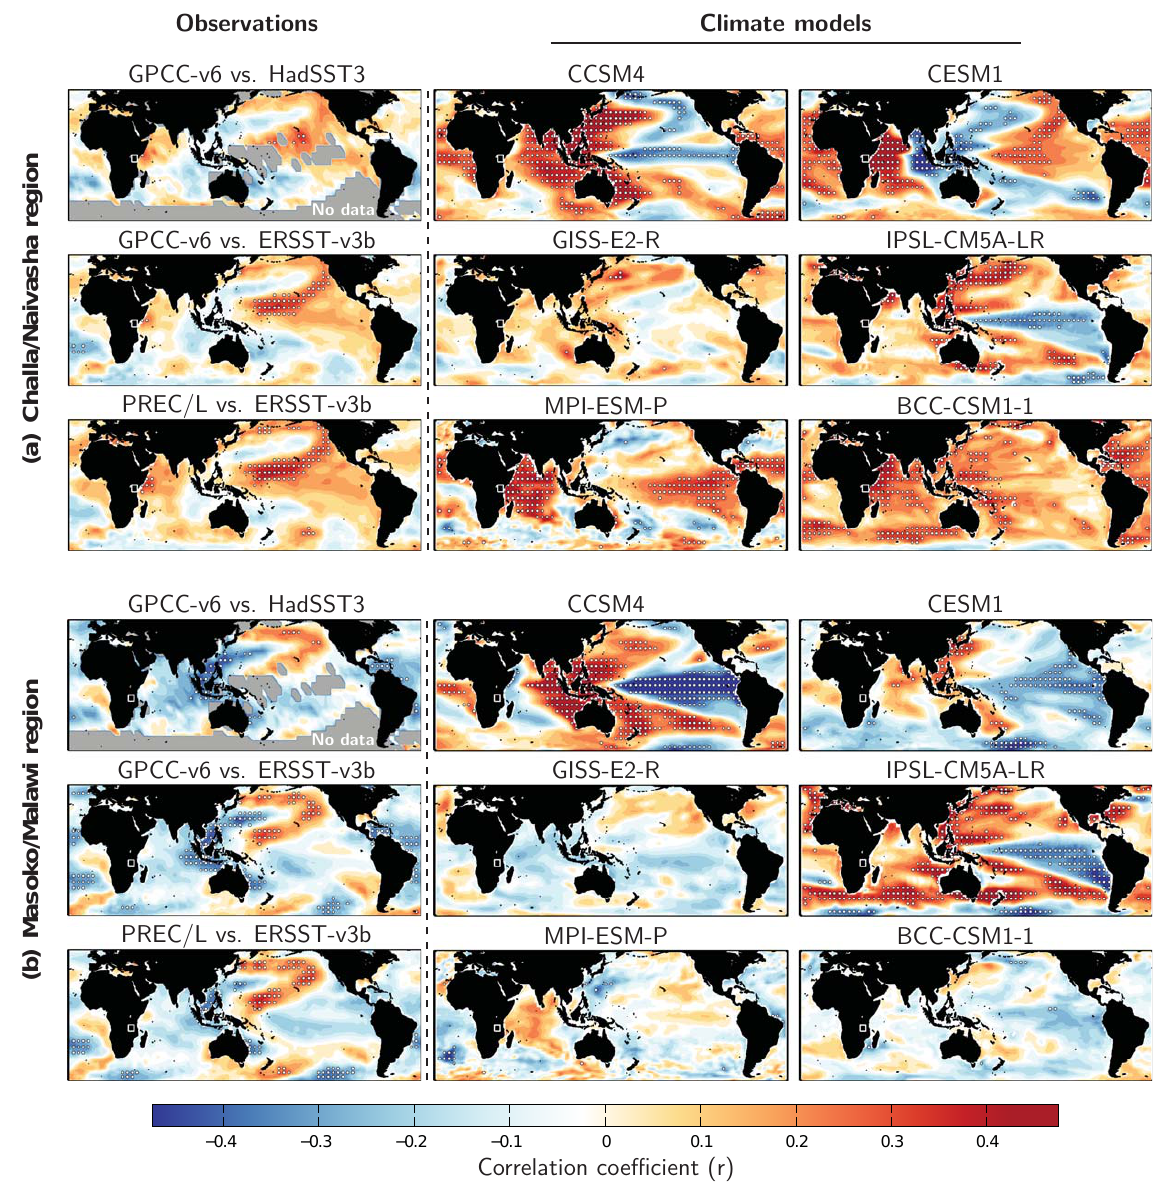
Figure 4. Pearson correlation coefficients between mean annual rainfall over the Challa–Naivasha region ( a , upper three rows) or Masoko– Malawi region ( b , lower three rows) and global SSTs in observations and climate models (here, only the first member r1i1p1 is used) for the period 1950–2000. In areas overprinted with white circles, a null hypothesis of no correlation can be rejected at the 5% level. No data are available from grey